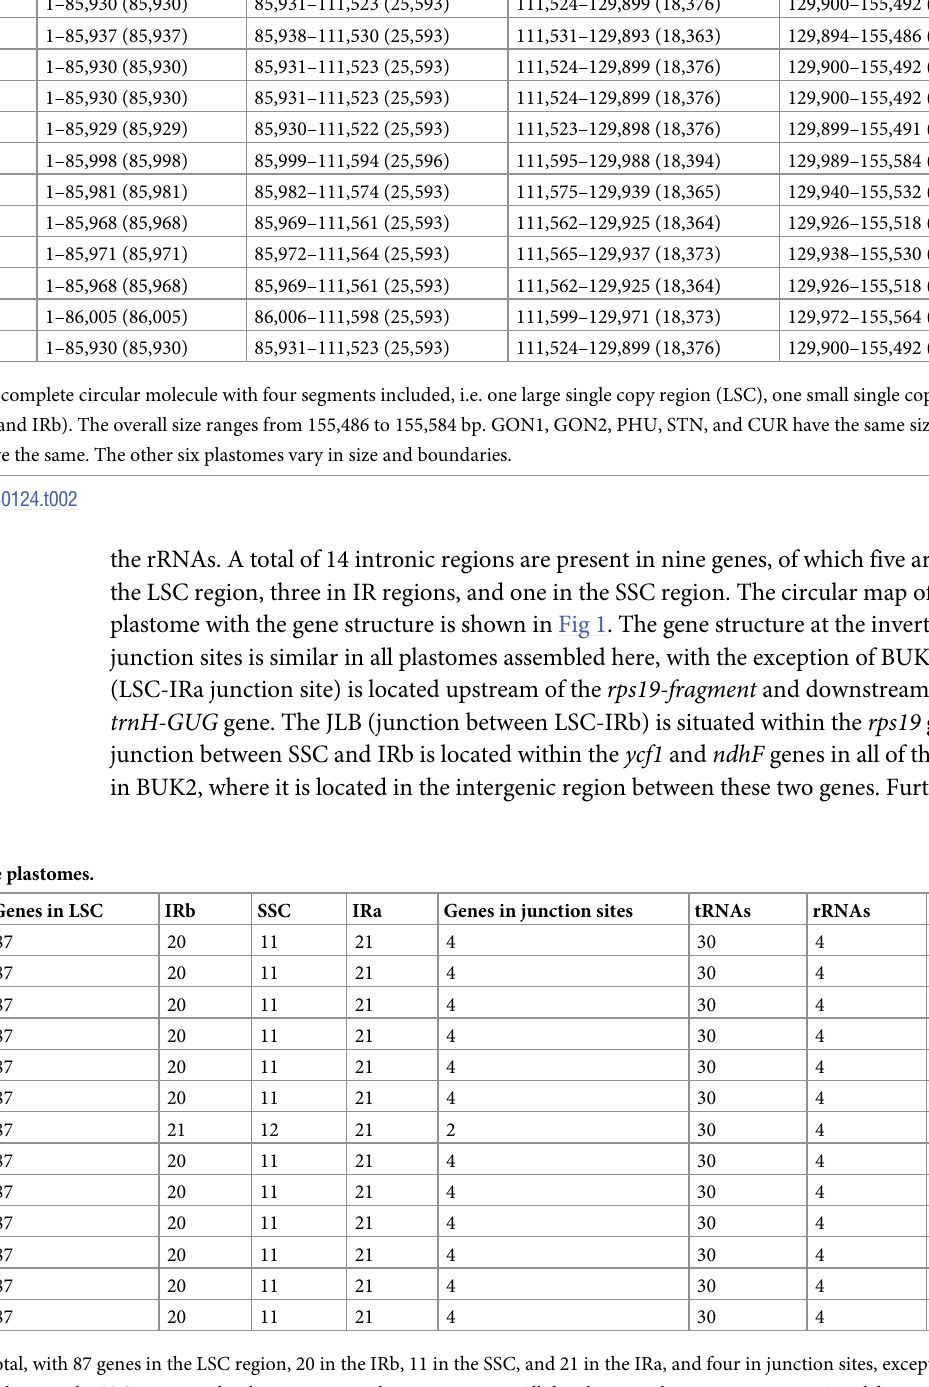
Table 2. Plastome size and range of individual segments.